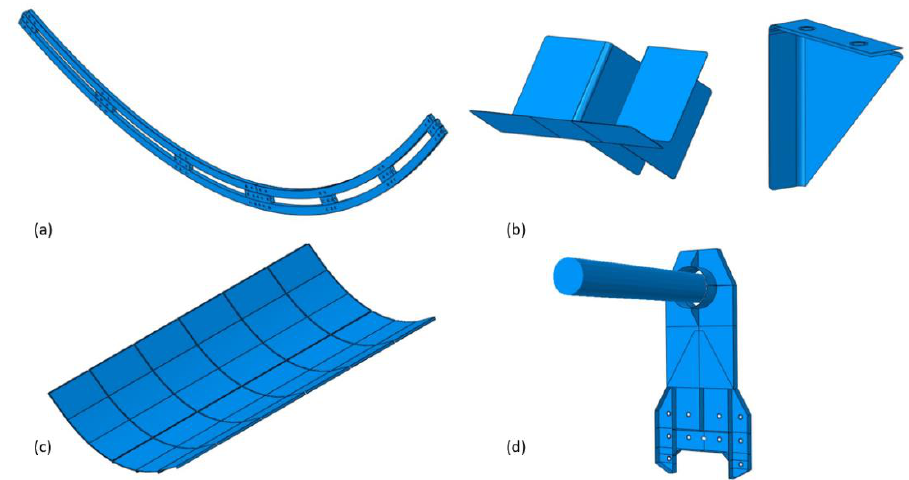
Figure 3. Numerical model of the most important parts of the trough: ( a ) end rib, ( b ) internal joints, ( c ) panel assembly, ( d ) king post.